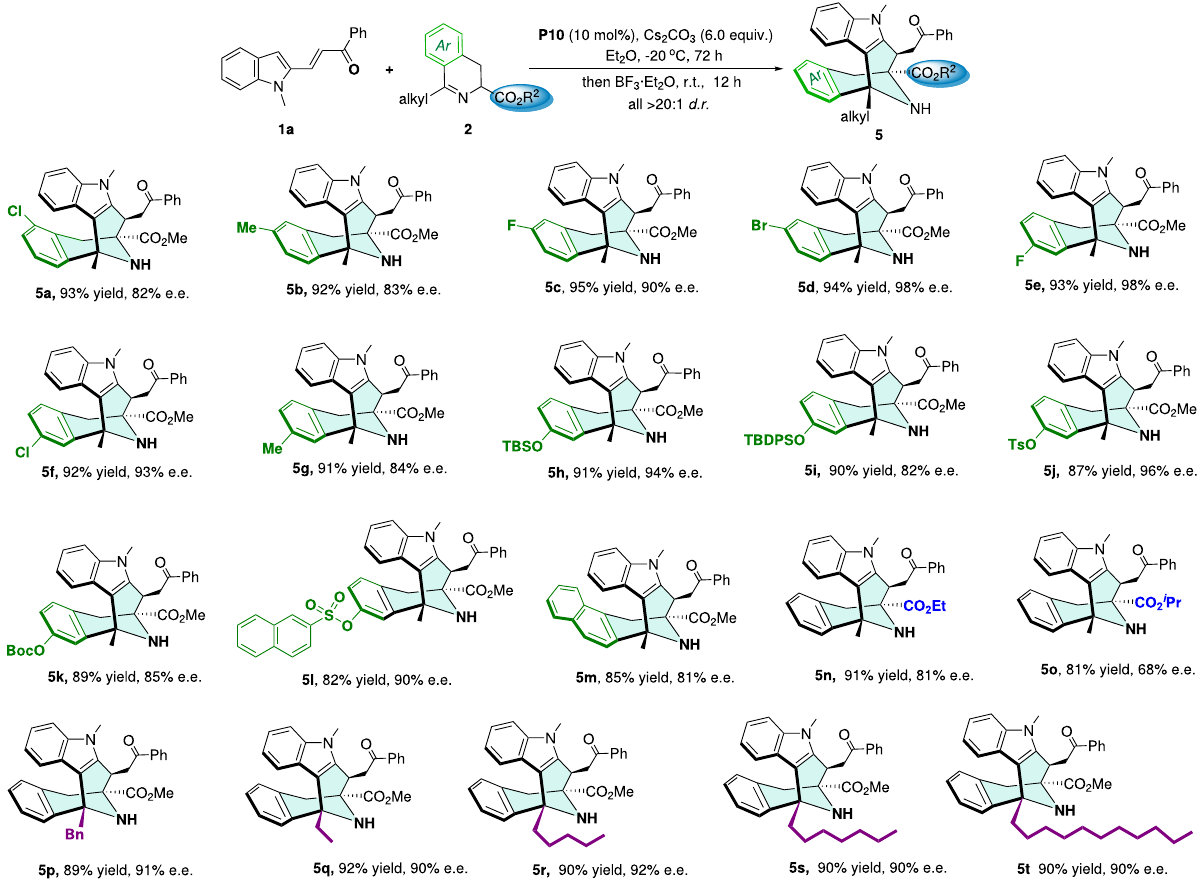
Fig. 5 Scope with respect to cyclic azomethine ylides. Reactions were performed with 1a (0.10 mmol), 2 (0.12 mmol), P10 (0.01 mmol), and Cs 2 CO 3 (0.60 mmol) in Et 2 O (2.0 mL) at − 20 °C for 72 h; then BF 3 ·Et 2 O (1.0 mmol) was directly added to the reaction mixture which was further stirred at r.t. for 12 h. Isolated yield. The e.e. value was determined by HPLC analysis on a chiral stationary